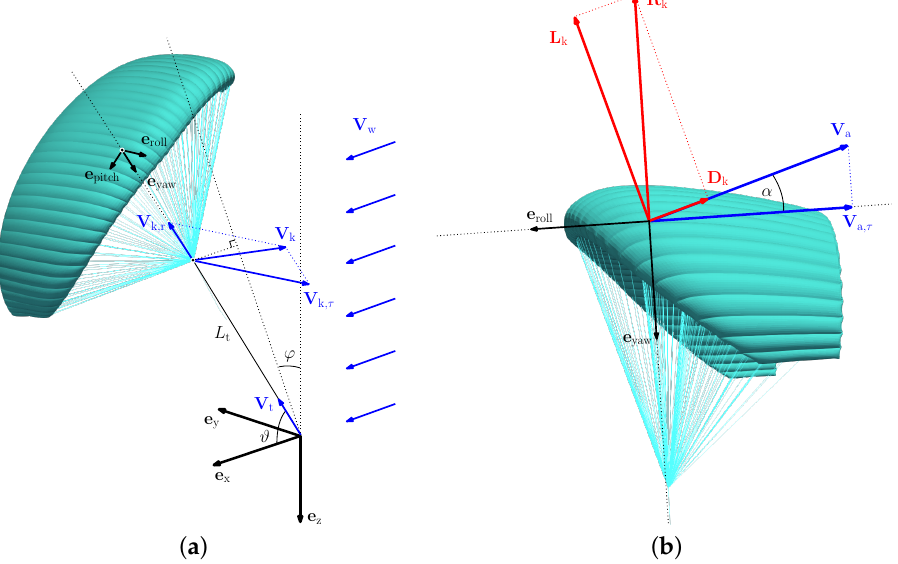
Figure 2. Velocities and forces acting on the kite in crosswind flight. Adapted from [20]. ( a ) Crosswind flight of a kite described with spherical coordinates ( ϑ , φ ) that are defined in the wind reference frame ( e x , e y , e z ). The flight velocity V k of the kite is decomposed into radial and tangential components, V k,r and V k, τ , respectively. Also shown is the body-fixed reference frame ( e roll , e pitch , e yaw ) of the kite. ( b ) Resultant aerodynamic force R K , its lift L K and drag D K components, its apparent wind velocity V a , and its component V a, τ perpendicular to the tether and along the roll axis of the kite. The angle of attack α is measured from the center rib’s chord line to the apparent wind velocity. Figure 3 depicts the initial condition of the virtual wind tunnel setup with a horizontal, linearly varying inflow and a vertical tether connecting via a bridle line system to the undeformed parafoil.